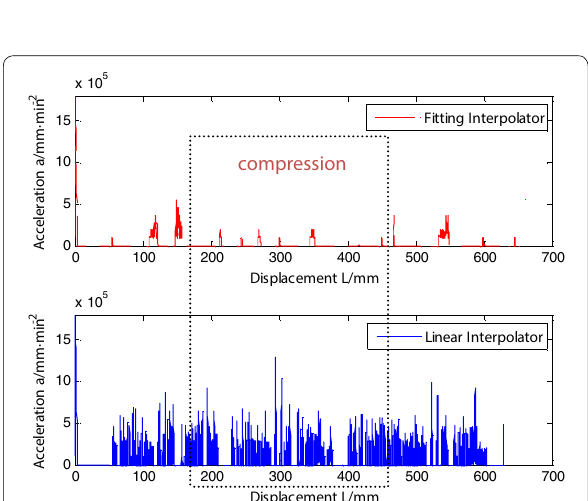
Figure 12 Acceleration profiles generated by two different interpolation